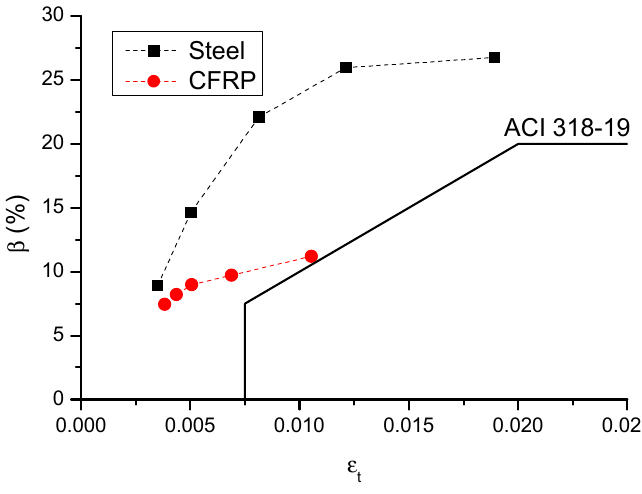
Figure 15. β – ε t relationship.